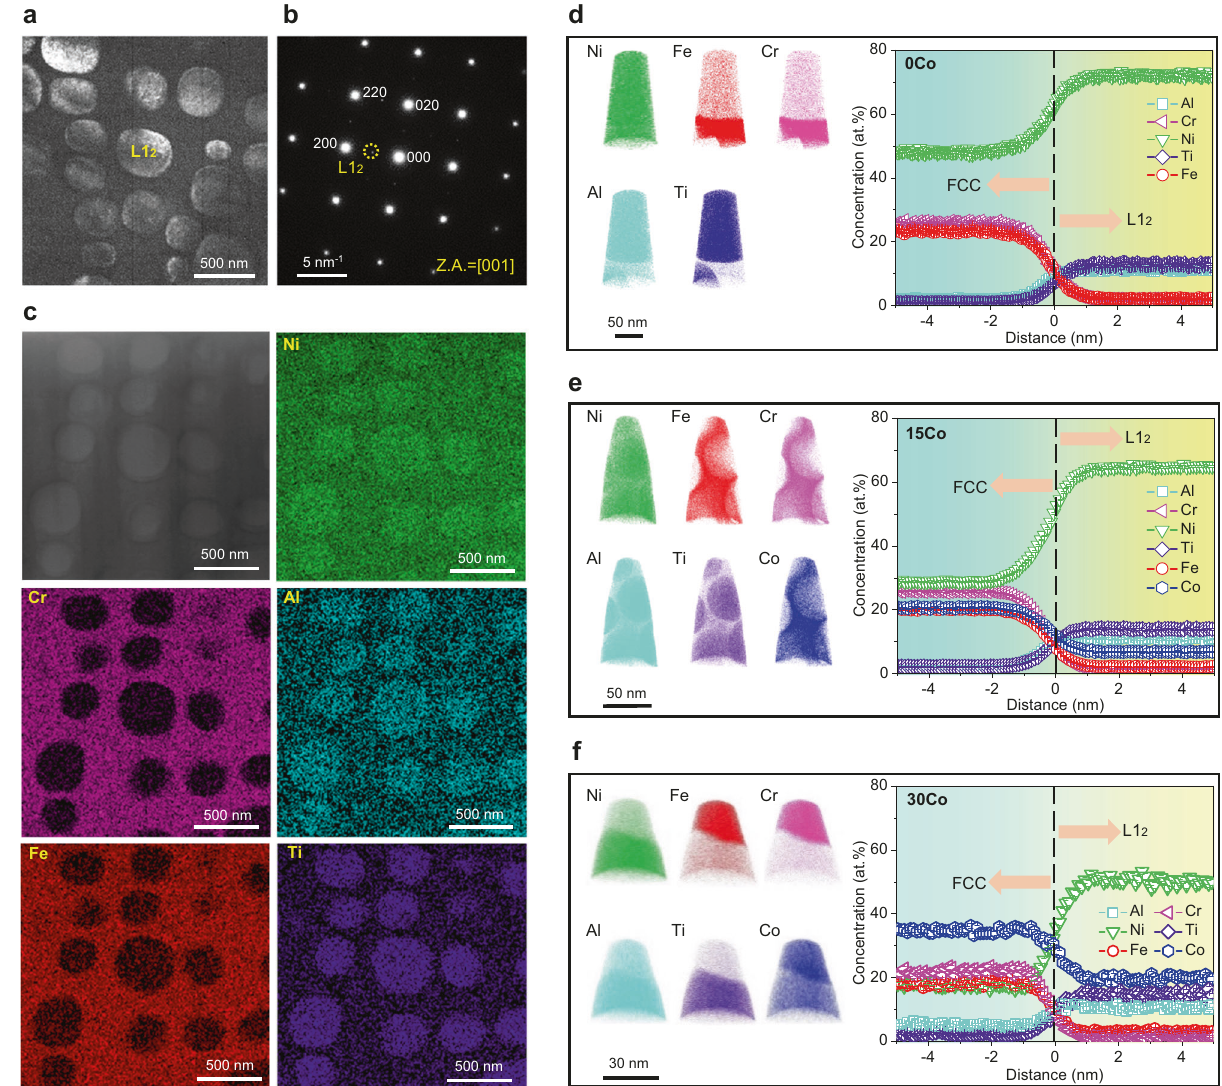
Fig.2|Structurecharacterizationandchemicalcompositionofnanoparticles. a A typical dark- fi eld TEM micrograph of nanoparticles in the 0Co CCA aged at 1000°C for 24h. b Nanoparticles are identi fi ed as L1 2 precipitates with the aid of SAED pattern (Z.A. denotes the zone axis). c The scanning TEM-EDS maps reveal